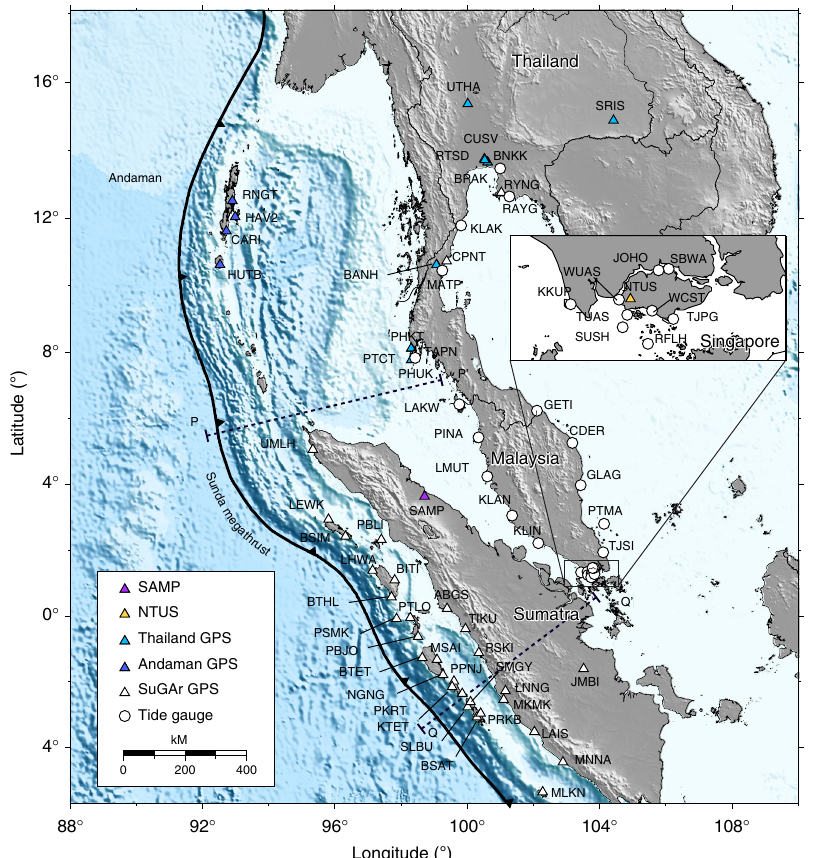
Fig. 2 Geographic locations of all the near- fi eld and far- fi eld geodetic sites used in our study. White triangles indicate SuGAr stations. Purple triangle represents SAMP operated by the Indonesian National Coordination Agency for Surveys and Mapping. Blue triangles show GPS stations from ref. 12 , where most of them are campaign sites established after the M w 9.2 2004 Sumatra – Andaman earthquake. Dark blue triangles are the four GPS stations on the Andaman Islands from ref. 28 . Open circles indicate tide gauges that provide the history of vertical land-height changes. The full name of the tide gauges are KKUP-Kukup,